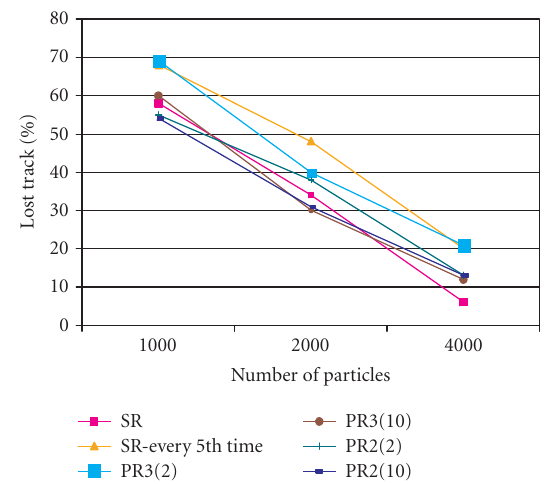
Figure 7: Number of times when the track is lost for the PR2, PR3, and SR applied to the bearings-only tracking problem.